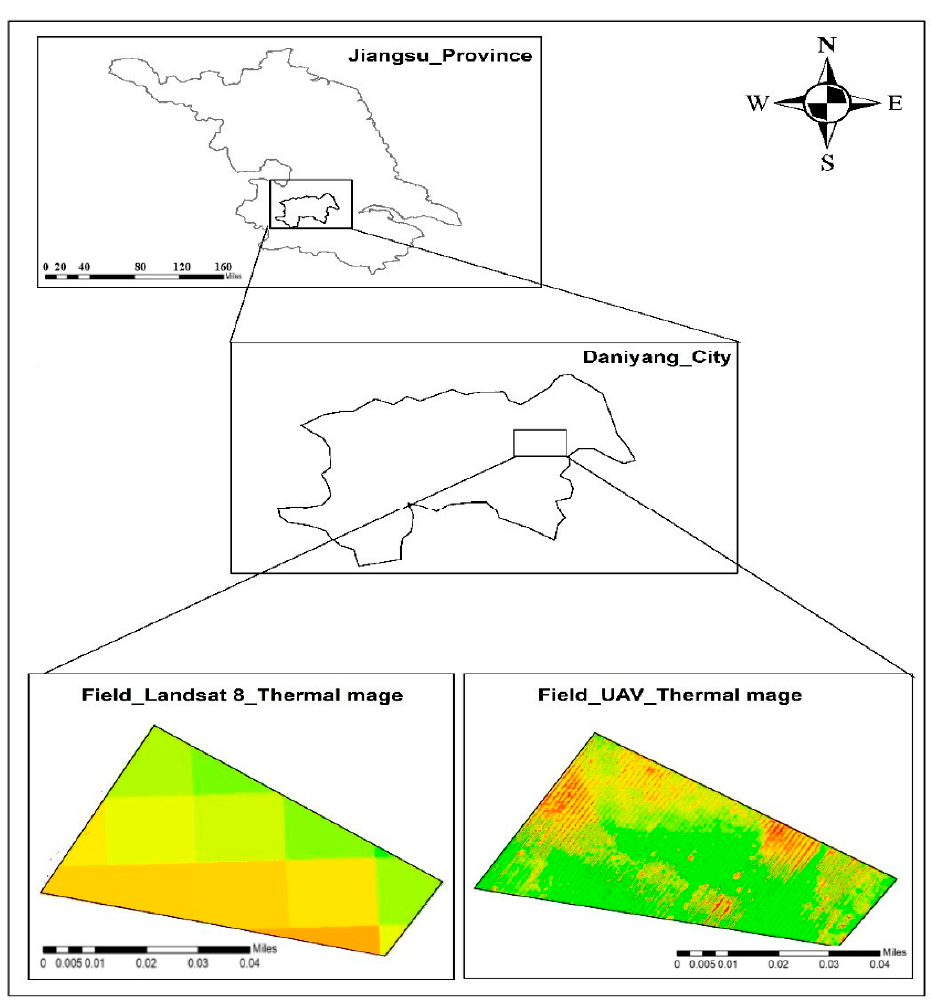
Figure 1. Study Area. Table 1. Instruments that were used during the experiment.